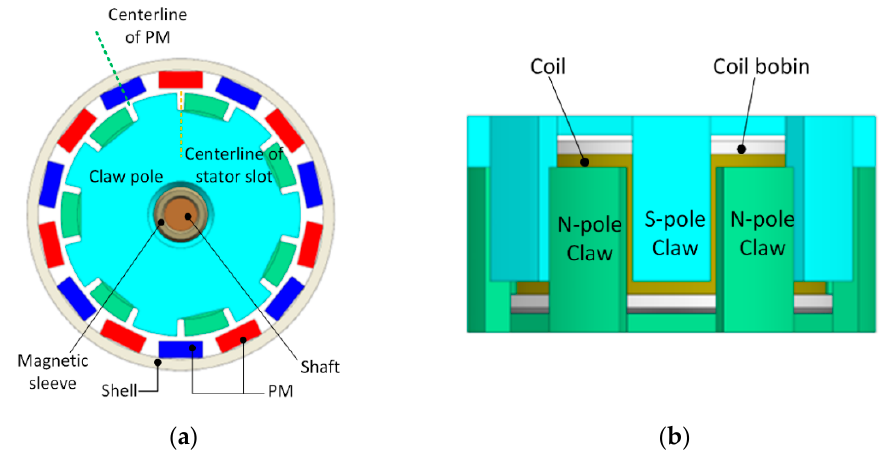
Figure 2. The structure diagram of CPMLTM. ( a ) Stator-rotor relative position diagram, ( b ) Stator structure diagram.